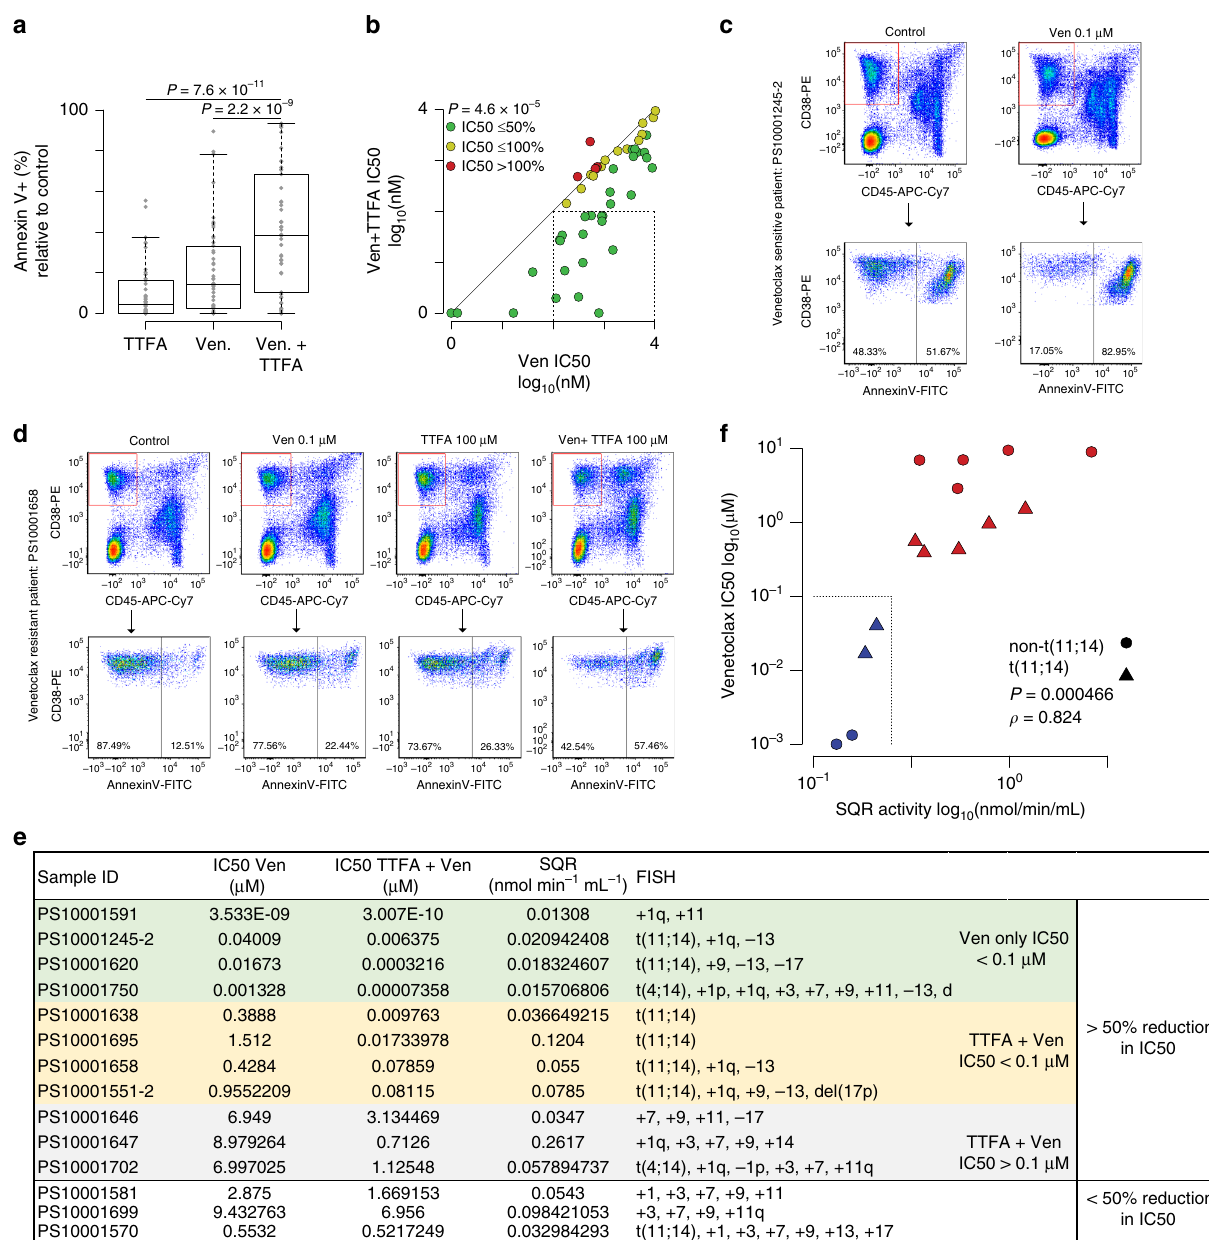
Fig. 6 SQR activity inversely correlates with venetoclax sensitivity in MM patient samples. a Box plot of cell death measured by Annexin V staining relative to vehicle control in samples from 50 myeloma patient bone marrow aspirates treated with 0.1 μ M venetoclax, 100 μ M TTFA alone or in the combination for 24 h. CD38-PE and CD45-APC-Cy7 were used to gate myeloma cells. n = 50 biological independent samples. Boxplots show the median and quartiles with the whiskers extending to the most extreme data point within 1.5 times the interquartile range. IC50 ± TTFA was calculated as indicated in supplementary Table 1. b Scatter plot of IC50 for patient samples treated with venetoclax (Ven; x -axis) vs. those treated with Ven and 100 µ M TTFA ( y -axis). A diagonal line denotes one-to-one correspondence of IC50. Samples are colored by the change in IC50 relative to the Ven group (green: ≤ 50%; yellow: 50 − 100%; red >100%). The dashed box denotes patient samples with Ven IC50s > 100 nM and Ven + TTFA IC50s ≤ 100 nM. Samples with an IC50 < 1 nM are plotted at 1 nM. p values were calculated using a paired Student ’ s t test. c , d Flow plots of representative patient samples (exhibiting high and low SQR activity) and corresponding sensitivity of MM-gated cells to venetoclax and/or TTFA cotreatment are shown. e Ven ± TTFA IC50, SQR activity and FISH characteristics of puri fi ed CD138 + myeloma cells from 14 patient samples. Samples additionally segregated on the basis of >50% reduction in IC50. f Scatter plot of SQR activity and Venetoclax IC50 showing a positive correlation (Spearman ’ s rank correlation ( ρ ) = 0.824, n = 14, p value = 0.000466). Samples are colored by Ven IC50 (blue: ≤ 0.1 µ M; red: >0.1 µ M). Triangles denote t(11;14) samples and circles denote non-t(11;14) samples. The dashed box denotes patient samples with Ven IC50 ≤ 0.1 µ M and SQR activity ≤ 0.25 nmol min − 1 mL − 1 . Source data are provided as a source data fi